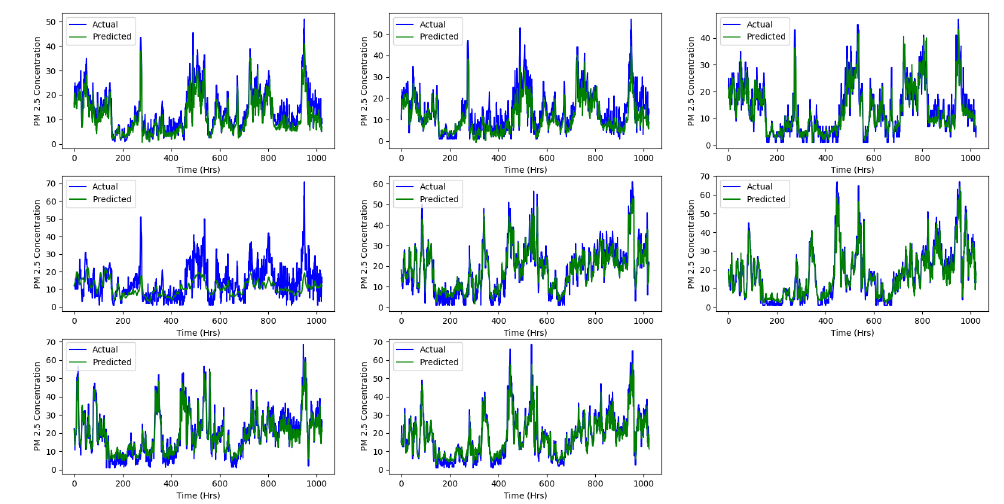
Figure 7. The predicted results of GRU.